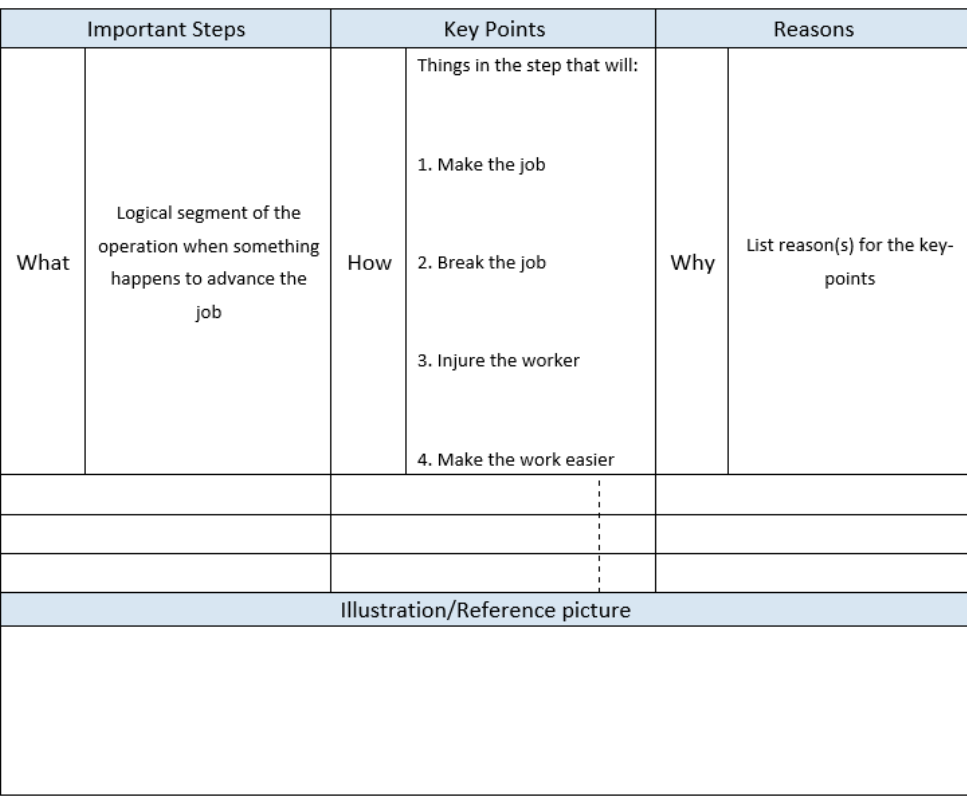
Figure 1. Conventional job element sheet.